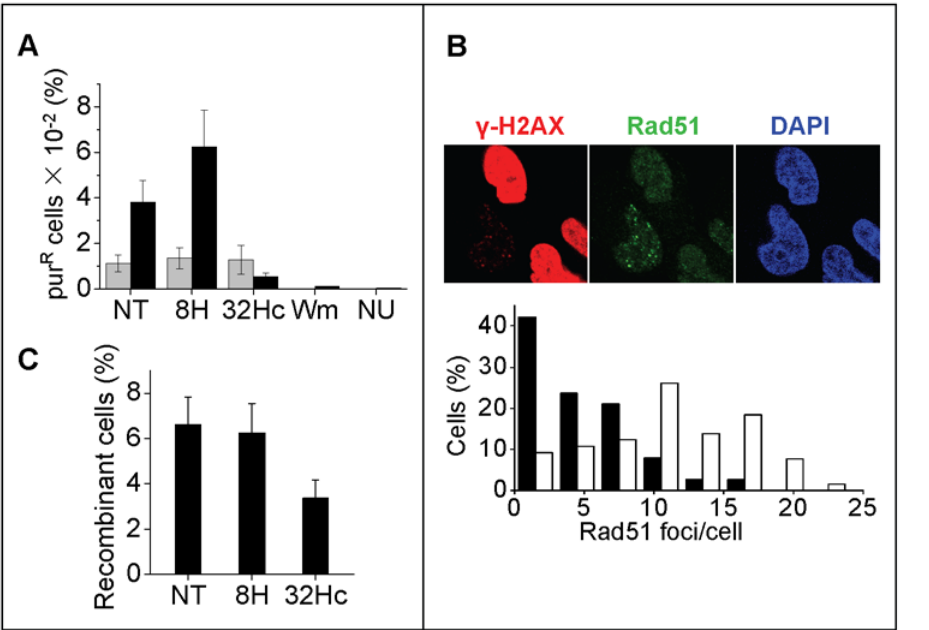
Figure 6. Effect of 32Hc on IRIF formation and DNA repair. (A) Inhibition of radiation-induced plasmid integration. Cells were transfected with 2 m g circular plasmid and 2 m g of 32Hc or 8H. The percentage of pur R cells having integrated the plasmid was calculated after 5 Gy irradiation (black columns) or without irradiation (grey columns) by dividing the number of colony-forming units in the presence of puromycin by the number of colony-forming units in the absence of puromycin for each transfection condition. The values indicated are means of at least three independent experiments. NU, NU7026; Wm, wortmannin. (B) Immunodetection of Rad51 (green) and c -H2AX (red) in irradiated MRC-5 cells (10 Gy). Cells were fixed 3 h after the end of transfection and IR. DNA was stained with DAPI. Scale bar: 20 m m. Histograms show the quantification (200 cells counted) of the number of foci in c -H2AX-positive (black) or negative (white) cells. The median values were four foci per c -H2AX-positive cells and 11 foci per c - H2AX-negative cells (C) Inhibition of HR. Human RG37 cells containing a tandem repeat of two inactive cassettes coding for EGFP (one of which contains a cleavage site for the meganuclease I-SceI) were transfected with HA-I-SceI expression vector and co-transfected with 8H, 32Hc or not (NT). Recombinant cells express functional EGFP and were measured by flow cytometry. The efficiency of transfection of HA-tagged-I-SceI was followed using an anti-HA antibody and was comparable for all three conditions.